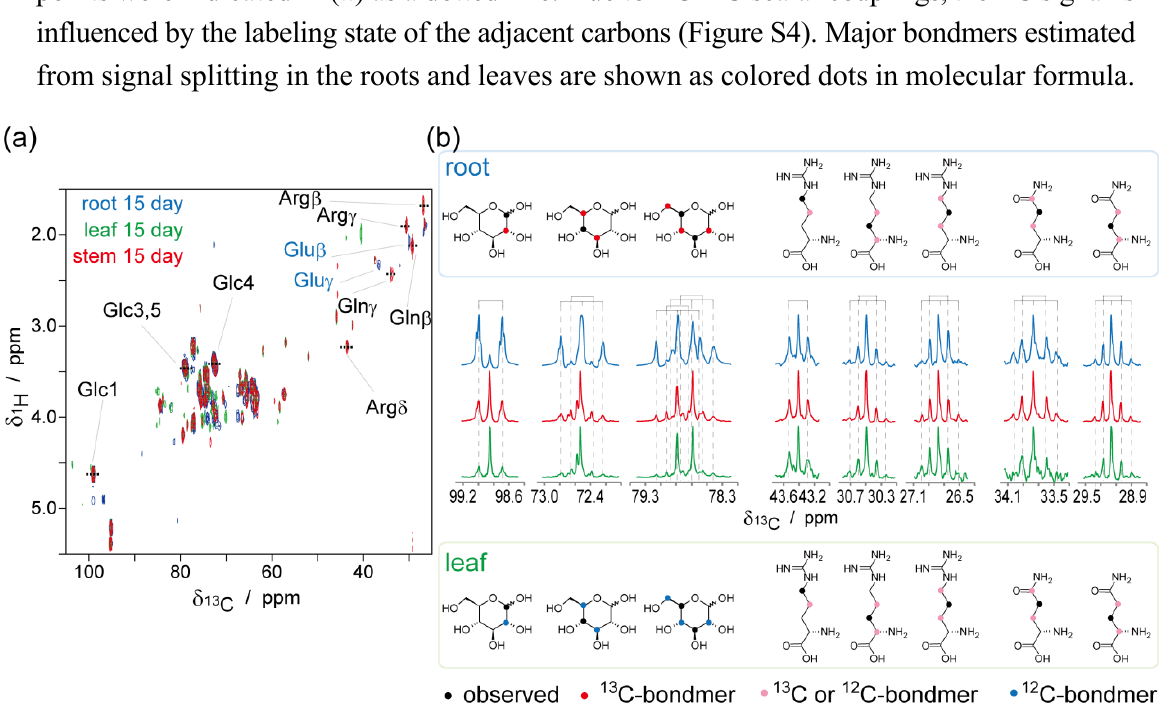
Figure 5. 13 C-detected 1 H- 13 C-HETCOR spectra during 13 C- 13/12 C bondmer analysis. ( a ) 13 C-detected 1 H- 13 C-HETCOR spectra of the roots (blue), leaves (green), and stems (red) at day 15; ( b ) The pseudo-1D 13 C spectrum generated from the 1 H- 13 C-HETCOR spectra. Generated points were indicated in ( a ) as a dotted line. Due to 13 C- 13 C scalar couplings, the 13 C signal